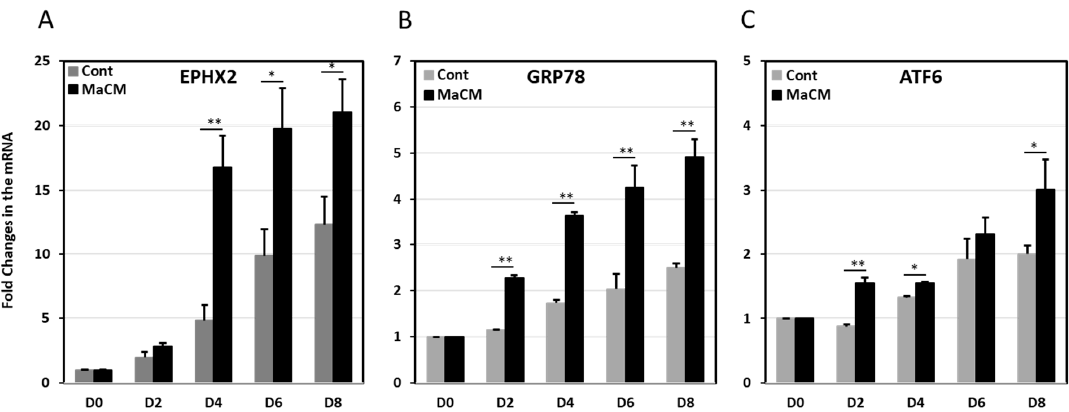
Figure 5. Expression levels of EPHX2 during the differentiation of 3T3-L1 preadipocytes and their treatment with a macrophage culture medium. mRNA expression levels of EPHX2 ( A ), GRP78 ( B ), and ATF6 ( C ) were measured by quantitative real-time PCR in 3T3-L1 preadipocytes (D0) and adipocytes differentiated for 8 days (D8) with and without macrophage-conditioned medium (MaCM). Data are presented as fold changes in differentiated adipocytes compared with preadipocytes from three independent experiments. * p < 0.05; ** p < 0.01.